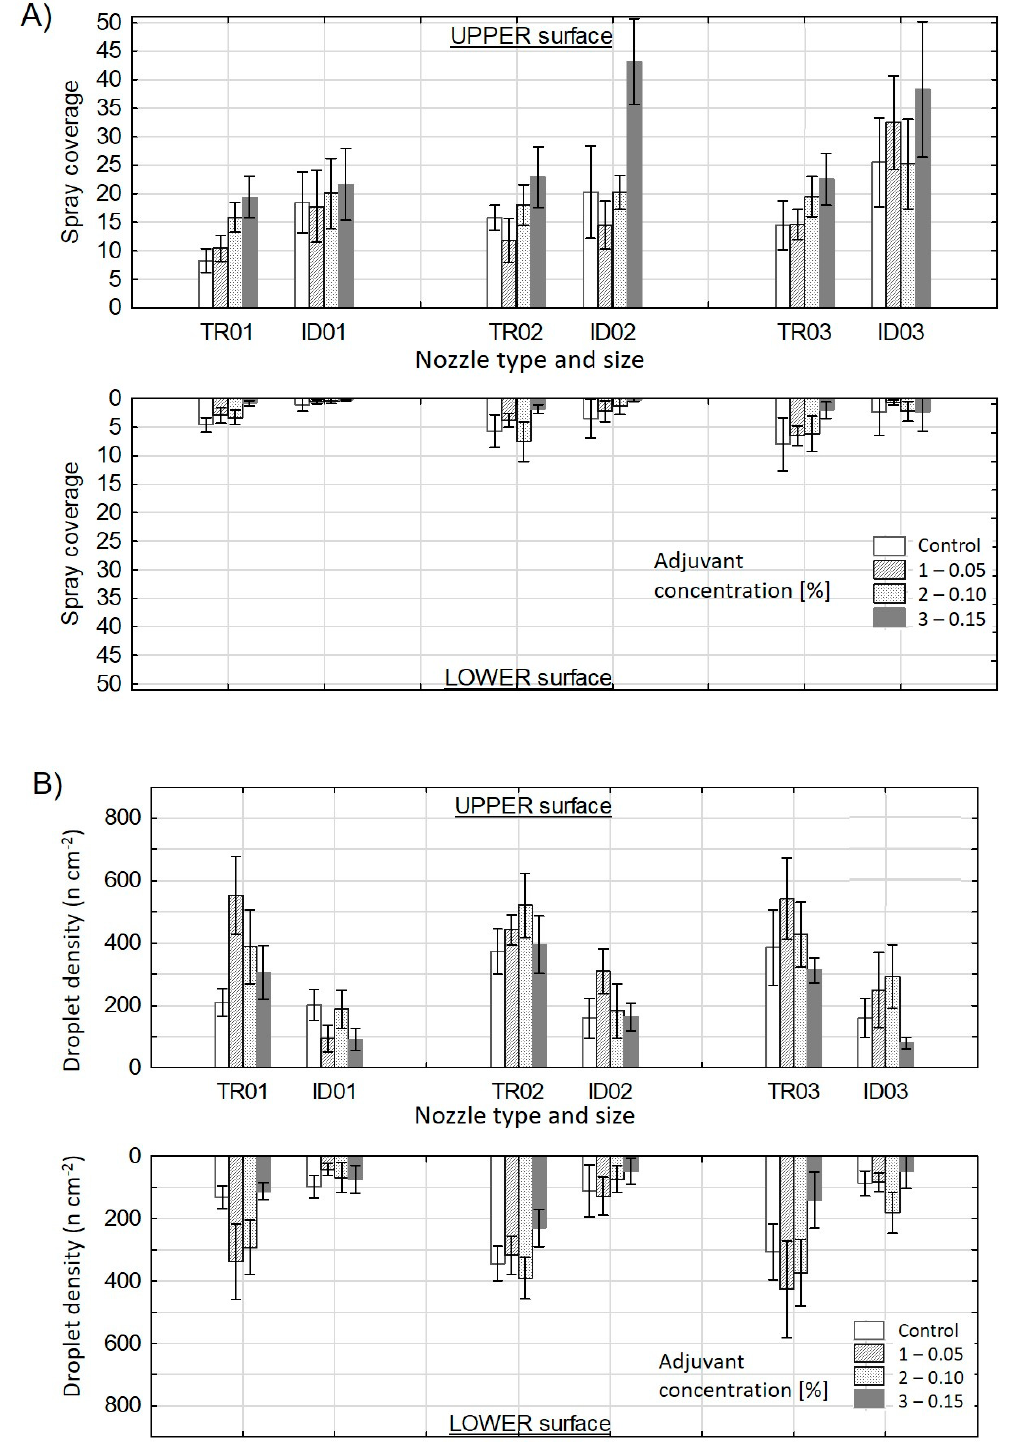
Figure 5. Effects of Silwet L-77 adjuvant concentration in spray liquid based on fungicide (dithianon—Delan 700 WG) and nozzle type and size (TR—fine spray hollow cone nozzles; ID coarse spray flat fan air-inclusion nozzles); nozzle sizes 01, 02, 03 acc. to ISO 10625:2018 on: ( A ) spray coverage on the upper and lower leaf surface (%) (mean); ( B ) droplet density on the upper and lower leaf surface (n cm − 2 ) (mean).